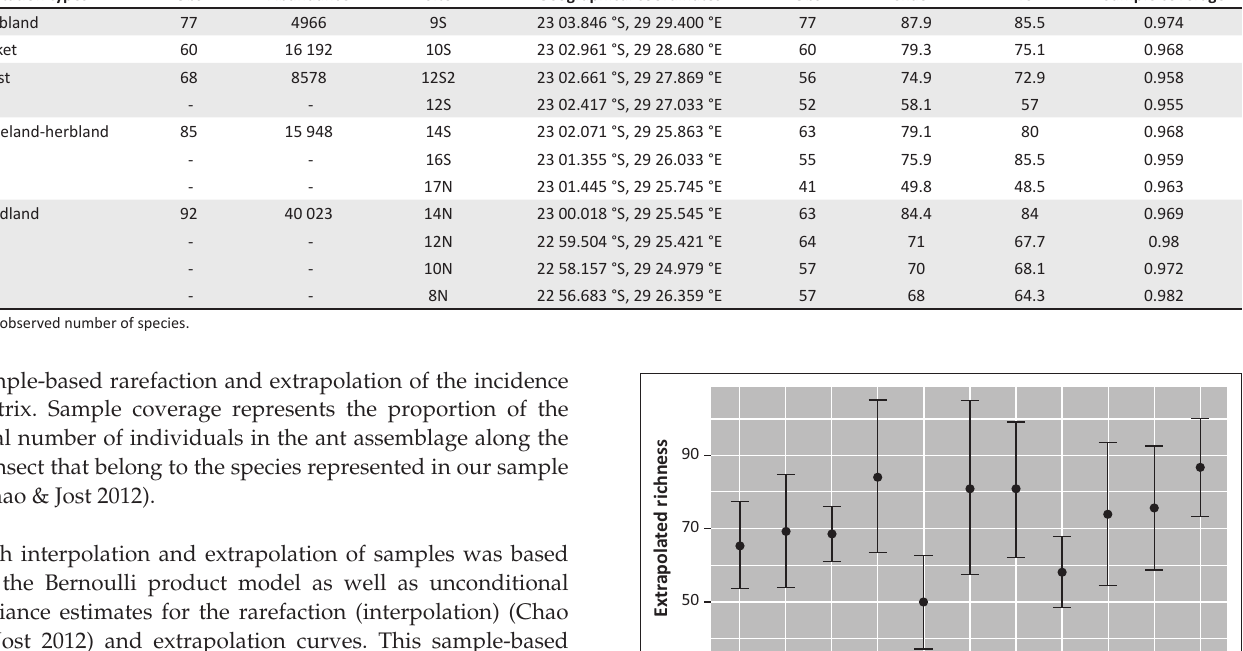
TABLE 1: Observed number of species, abundance, richness estimates (Chao 2 and ICE, available in EstimateS 9.1.0 package) and sample coverage for broad structural vegetation types and 11 sites with their geographical coordinates along the Soutpansberg transect. Vegetation types Obs Abundance